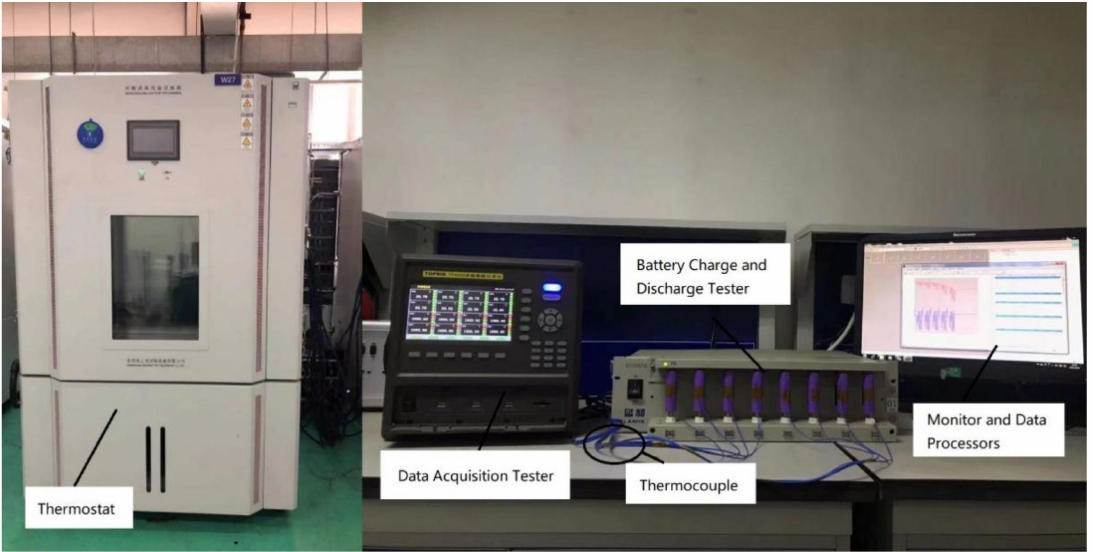
Figure 3. Experimental